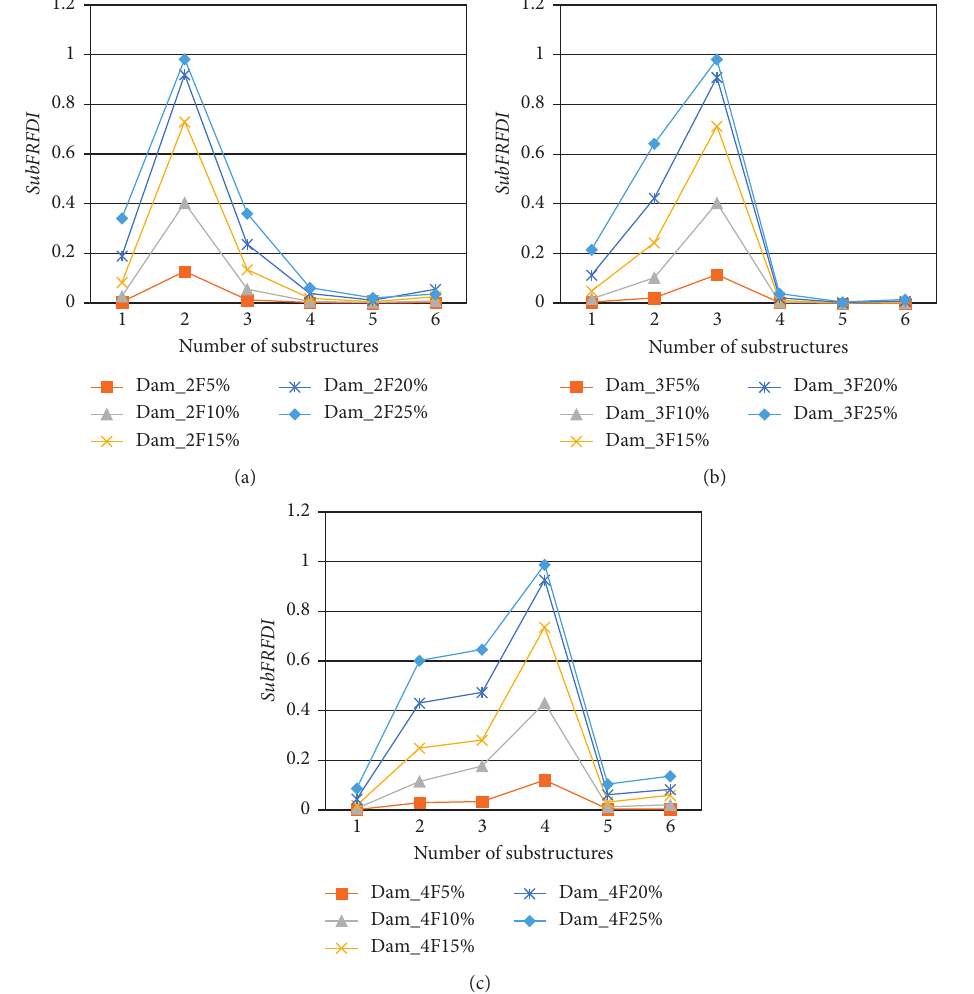
Figure 10: The comparison of the SubFRFDI for 5%, 10%, 15%, 20%, and 25% stiffness reduction in (a) the 2 nd floor, (b) the 3 rd floor, and (c) the 4 th